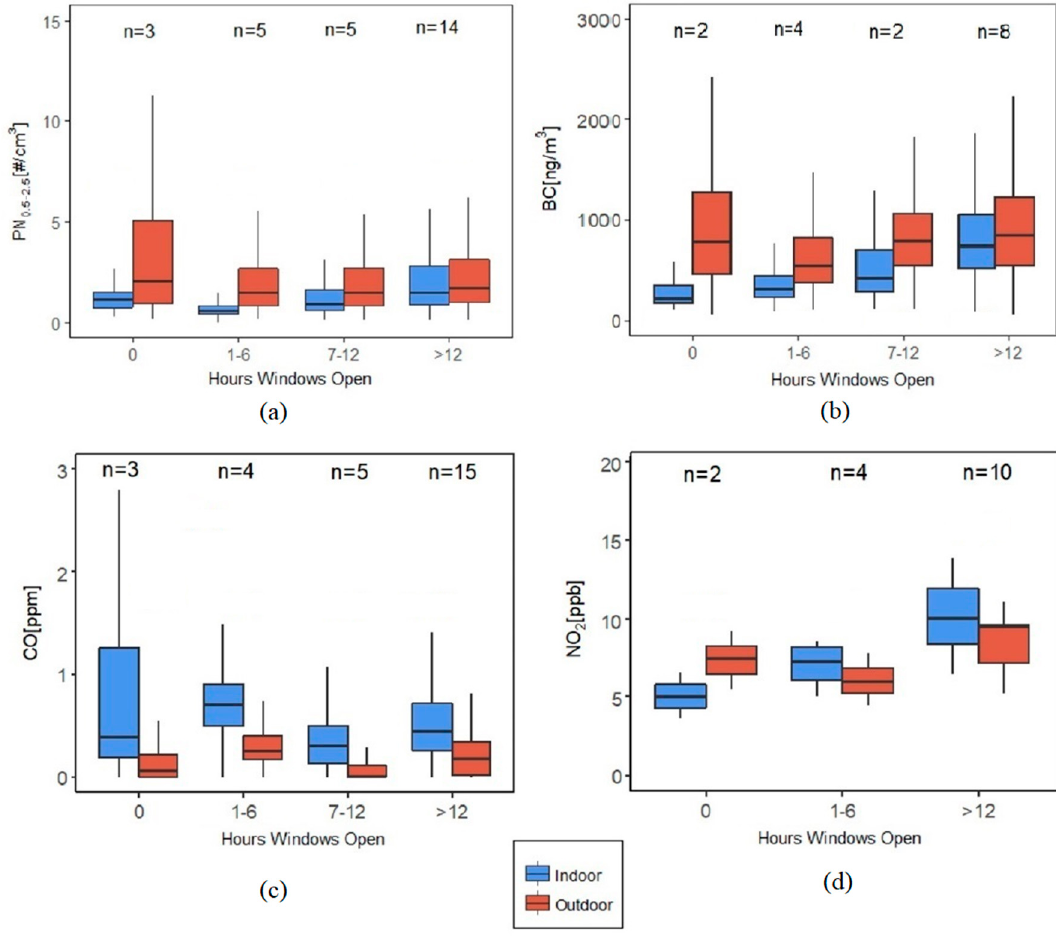
Figure 11. Indoor and outdoor pollutant concentration distributions (not showing outliers) according to the hours of window opening (filtered dataset) for ( a ) PN 0.5-2.5 , ( b ) BC, ( c ) CO and ( d ) NO 2 . The indoor and outdoor mean concentrations were significantly different across all window opening intervals for all pollutants except for NO 2 (K-W test at α = 0.05).